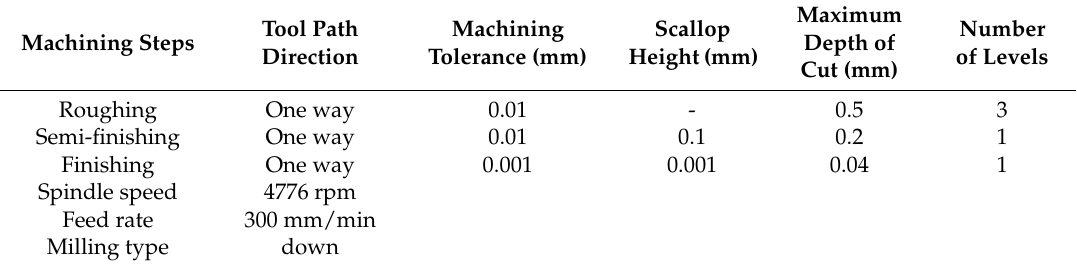
Table 3. Operation and cutting